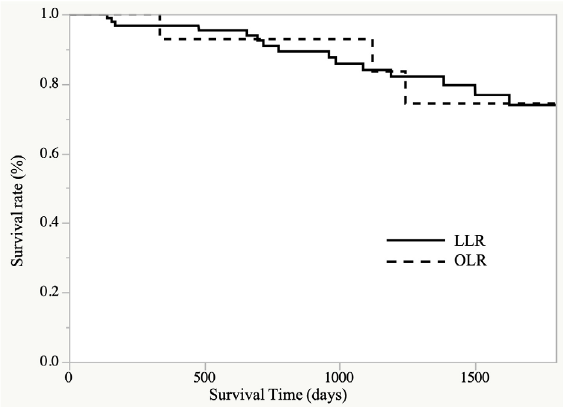
Figure 5. Overall survival after LLR and OLR groups.